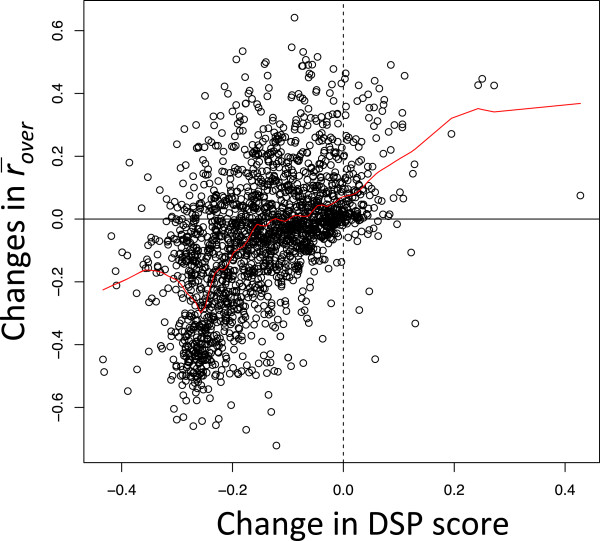
Correlation of the DSP score and consistency with COG. Each circle represents a pair of ortholog clusters that was one of the targets of the merge procedure. The red line was drawn by the lowess function of R with parameter f = 0.1.